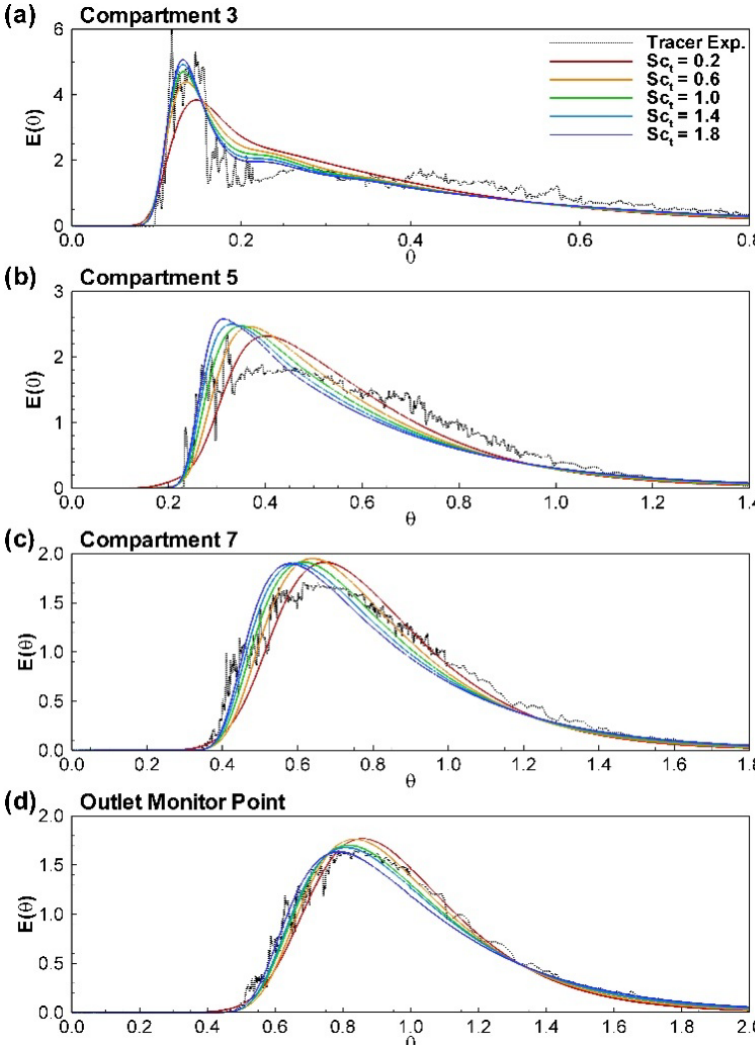
Figure 3. Residence time distribution curves predicted for different sampling points at the tracer sampling points at: ( a ) z/H t = 0.5 in Compartment 3; ( b ) z/H t = 0.5 in Compartment 5; ( c ) z/H t = 0.5 in Compartment 7; and ( d ) at the outlet.